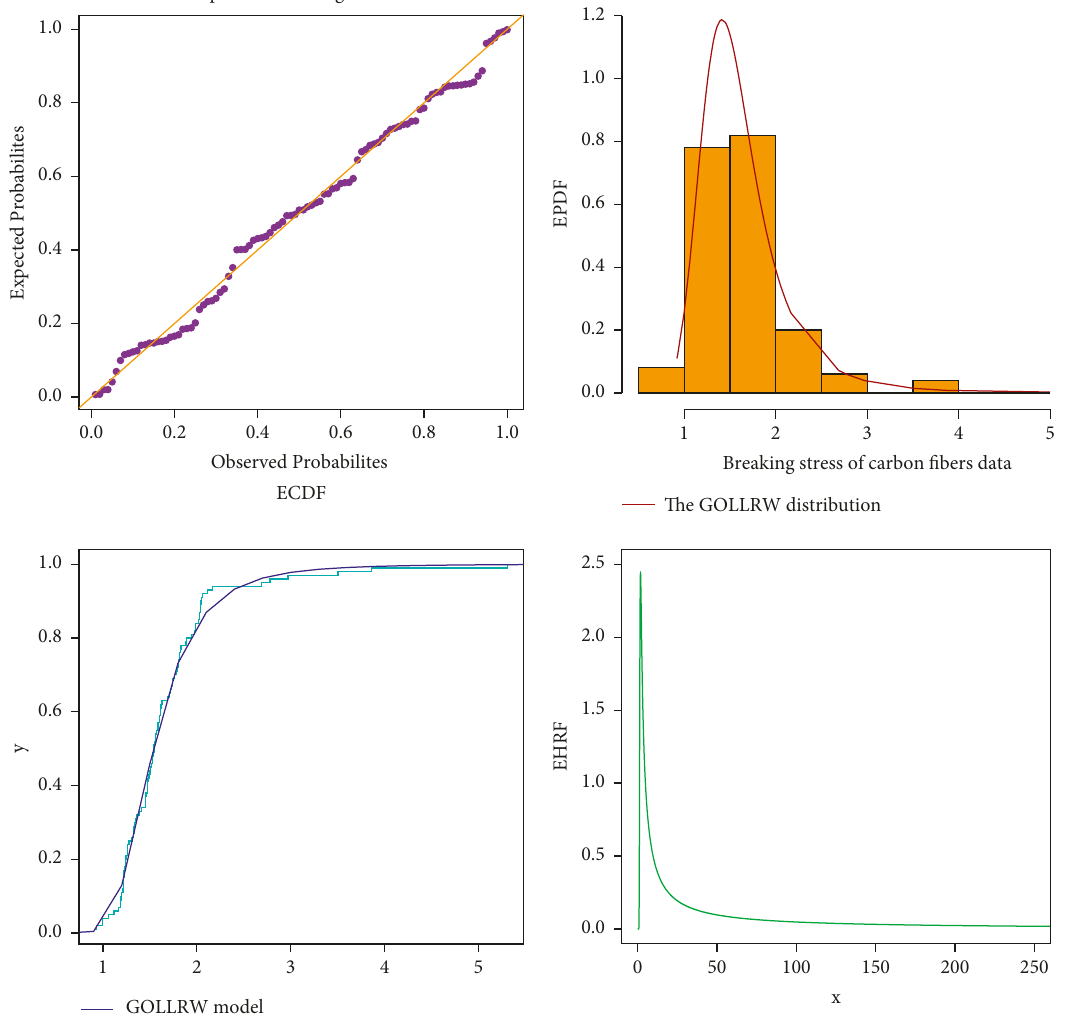
Figure 4: P-P plot, EPF, ECDF, and EHRF for stress data set.